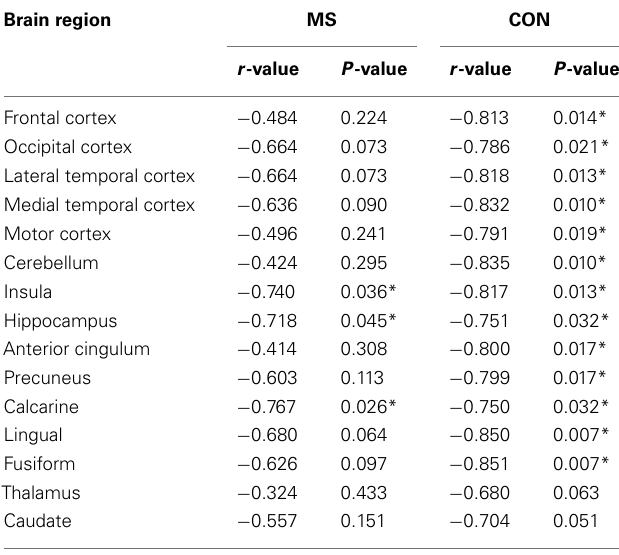
Table 3 | Pearsons’ correlations between walking speed and brain region FDG uptake